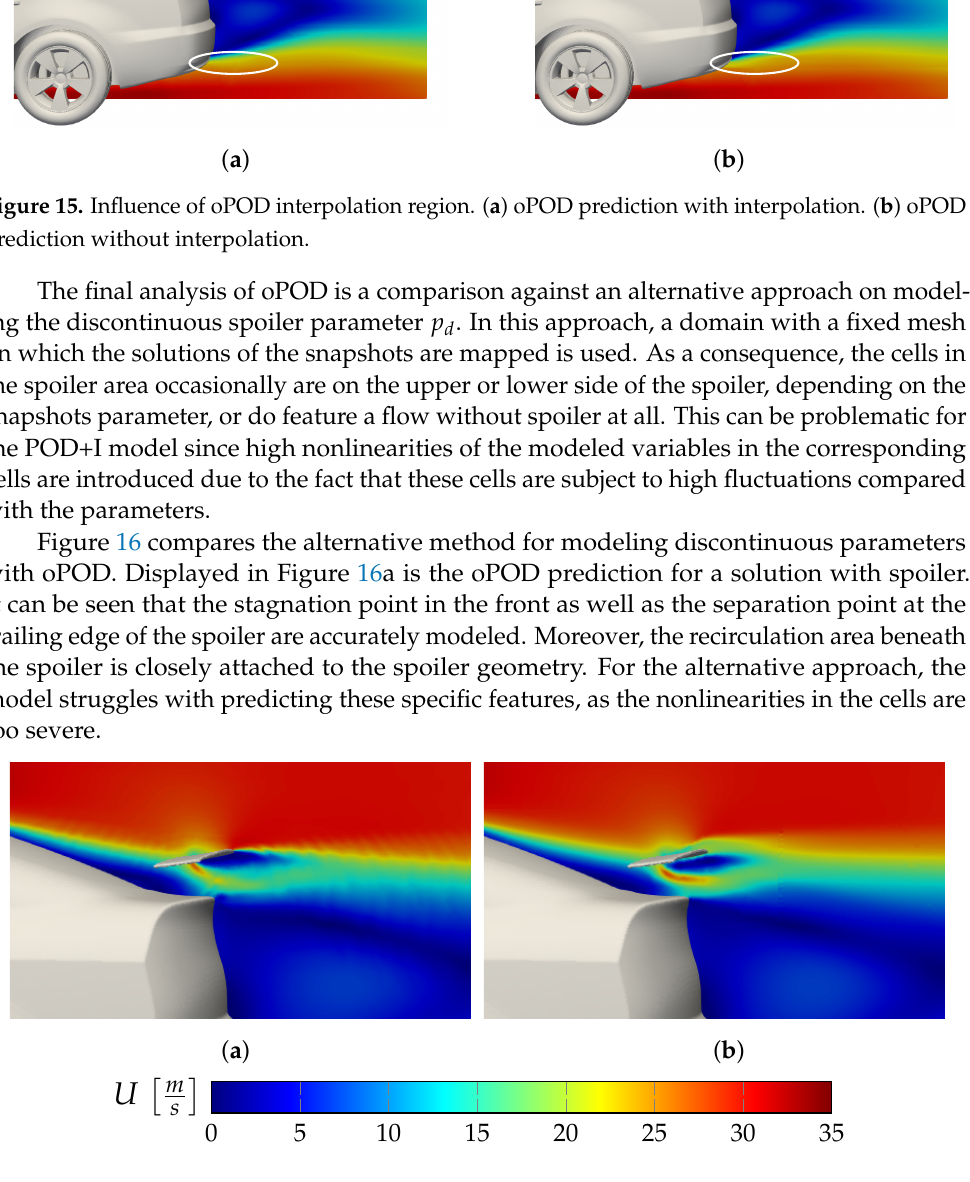
Figure 14. CFD solutions and oPOD predictions for c p at p ∗ with and without spoiler.